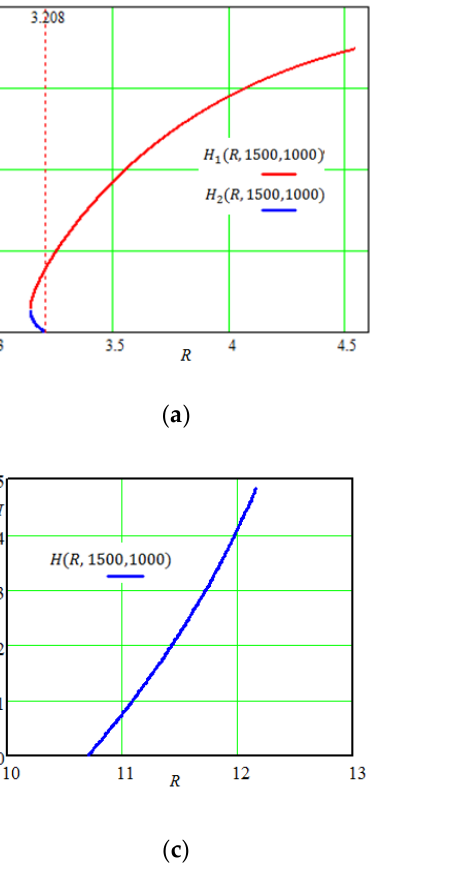
Figure 19. The set of the correct solutions of Equation (18), taking into account the physical meaning: ( a ) first subdomain of solutions H ( R , V , S ) ; ( b ) values of L S ( R , S , H ) = L V ( R , V , H ) , corresponding to the first subdomain; ( c ) the second subdomain of the solutions H ( R , V , S ) ; ( d ) values of L S ( R , S , H ) = L V ( R , V , H ) corresponding to the second subdomain. It is possible to define up to third digit the boundaries of the first sub-region of solutions as 3.146 ≤ R ≤ 4.578, and with 3.146 ≤ R < 3.208 there are two roots H 1 ( R , 1500, 1000 ) and H 2 ( R , 1500, 1000 ) , while with R ≥ 3.208 only one H 1 ( R , 1500, 1000 ) . The second subdomain of the solutions is defined for 10.708 ≤ R ≤ 12.157, and here there is only one root H ( R , 1500, 1000 ) . The corresponding 3d-plot of the solution area ( H , L , R ) , calculated analytically taking into account the physical meaning of the variables, is shown in Figure 20.